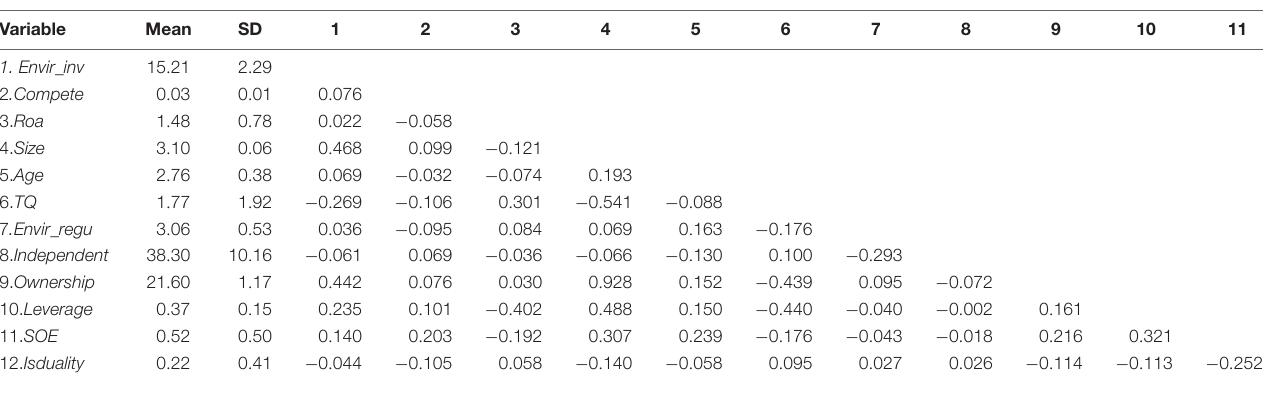
TABLE 1 | Summary statistics deviations and correlation matrix. Variable